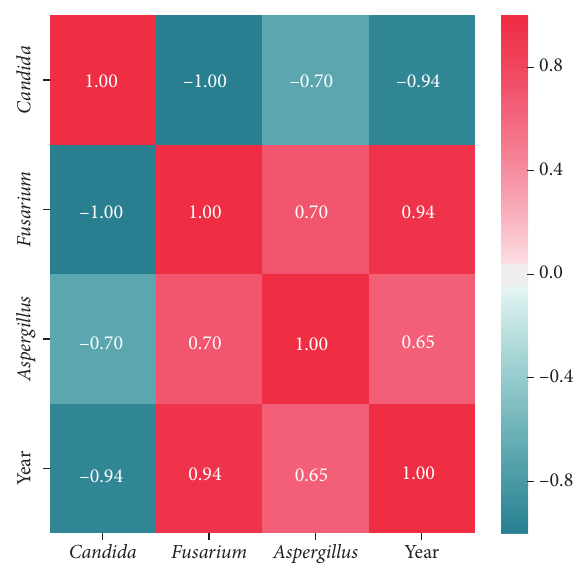
Figure 2: The matrix of correlations b.